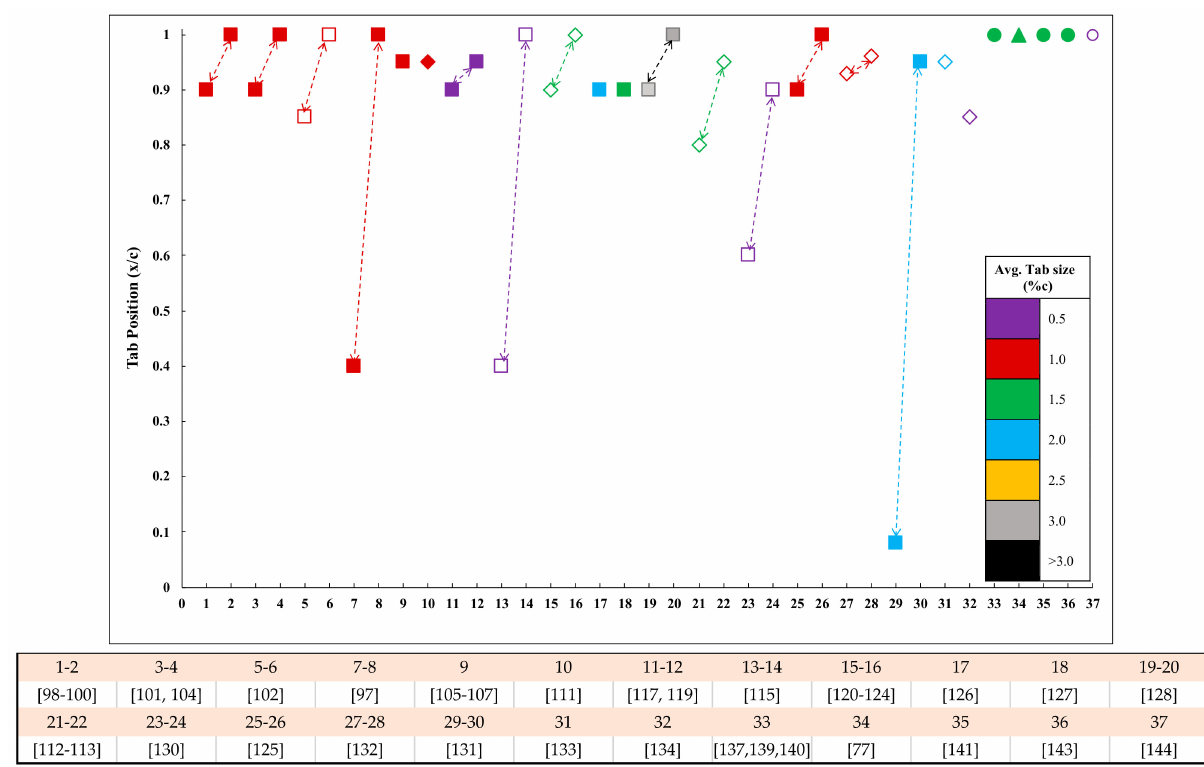
Figure 7. Literature survey of microtabs and miniature trailing-edge effectors (MiTE). (The empty and filled markers correspond to the numerical and experimental investigations, respectively. The arrows indicate the range of